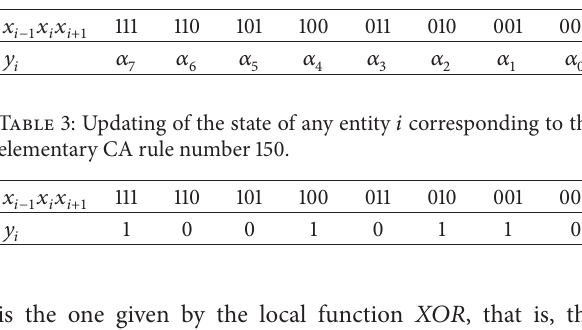
Table 2: Denomination of the updating of the state of any entity 𝑖 to establish the procedure to enumerate elementary CA rules.